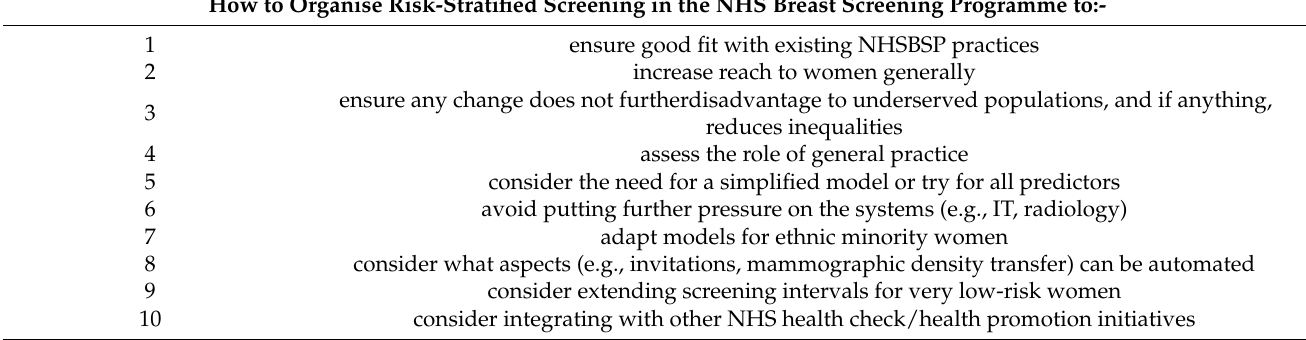
Table 1. Indicative uncertainties provided for group